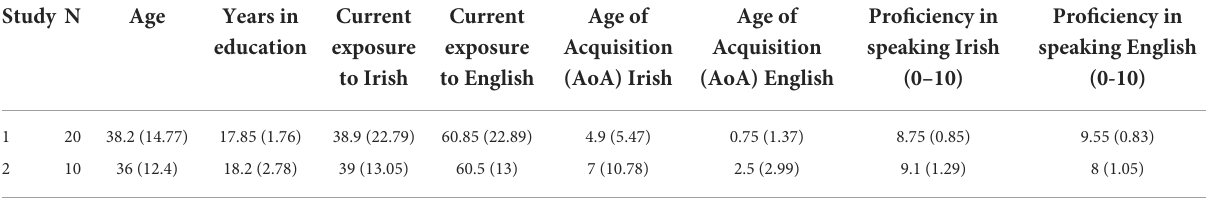
TABLE 1 Demographic and language variables reported through LEAP-Q (Marian et al., 2007) for Study 1 and Study